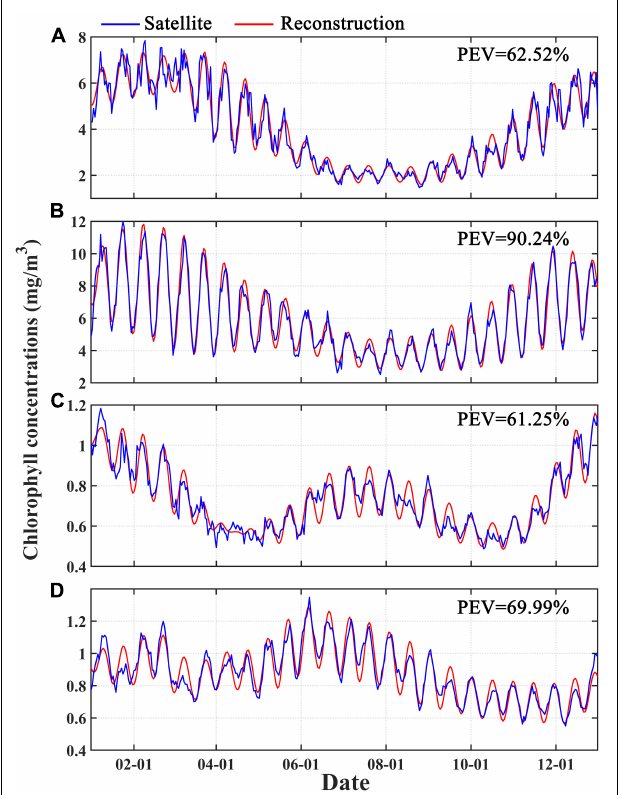
FIGURE 5 | One-year satellite-merged and reconstructed Chl- a derived by wavelet reconstruction for the spring-neap tide cycles in four typical areas (A–D) . PEV represents the proportion of explained